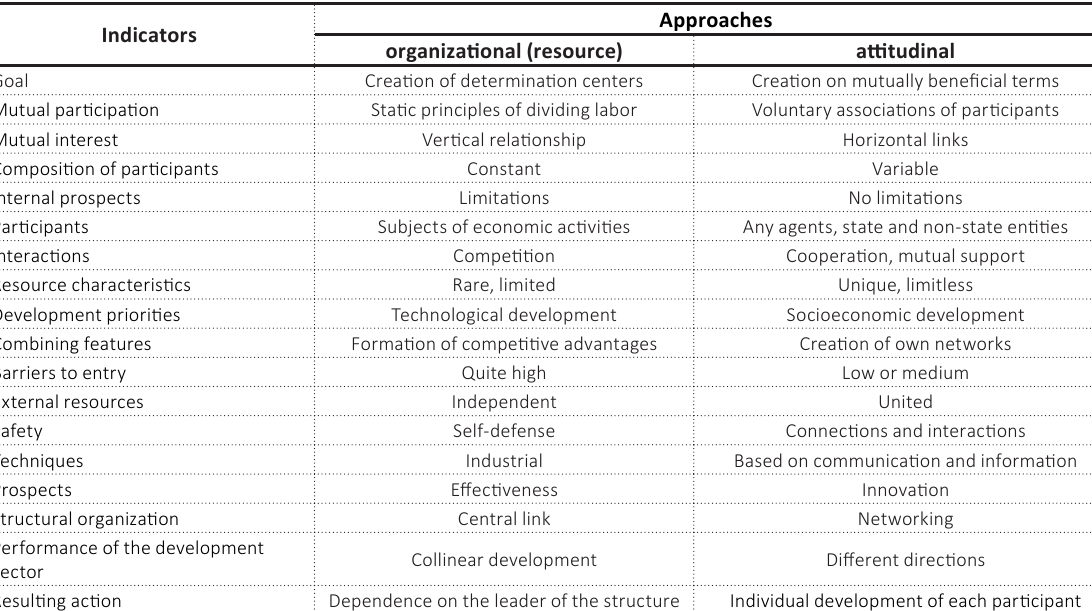
Table 3. Approaches to governing